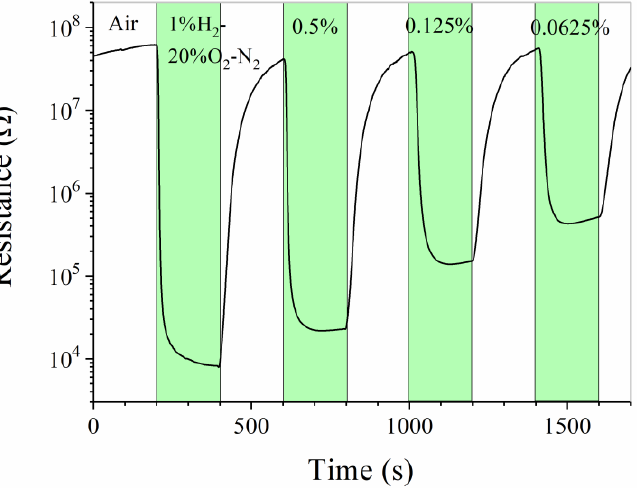
Figure 4. Resistance responses of a sample of 5 wt% Pt sintered at 825 °C to a series of concentrations of H 2 in 20% O 2 – N 2 at room temperature (25 °C), and recovery in air of 40% RH.